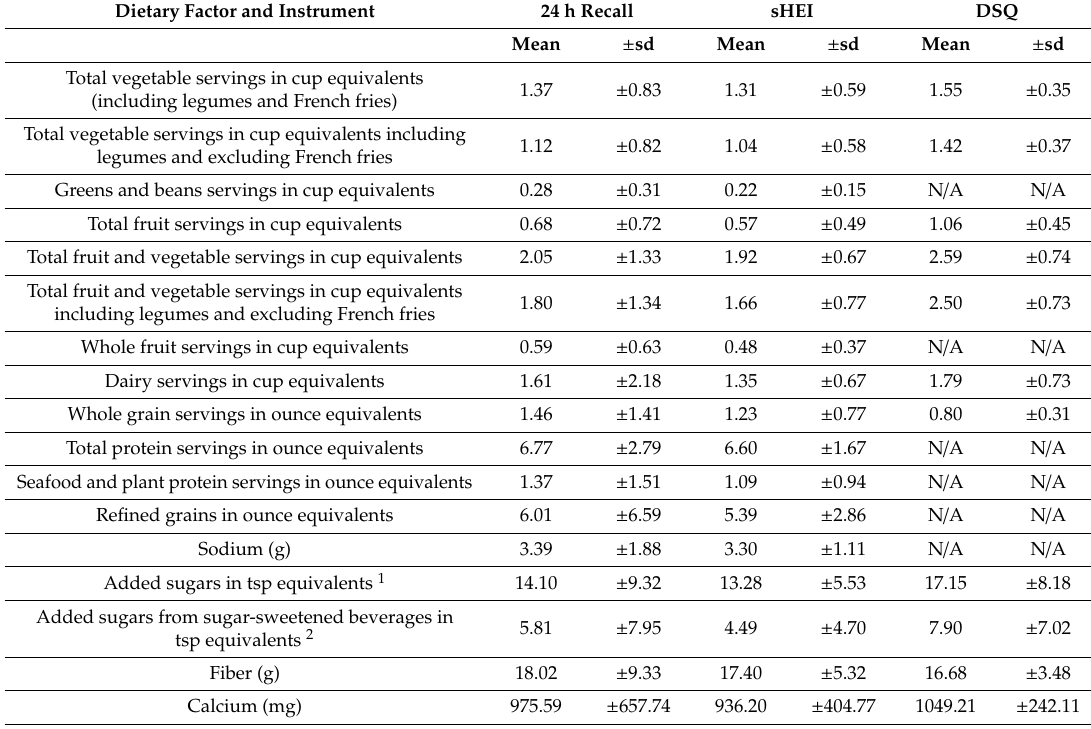
Table 1. Estimated Food Group Consumption by Instrument (24 h Recall, the sHEI, and the DSQ). Dietary Factor and Instrument 24 h Recall sHEI DSQ Mean ± sd Mean ± sd Mean ± sd Total vegetable servings in cup equivalents 1.37 ± 0.83 1.31 ± 0.59 (including legumes and French fries)